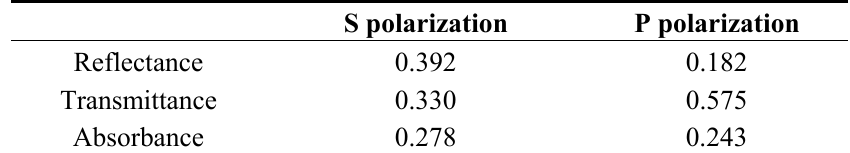
Table 1. Calculated optical factor of the beam splitter.